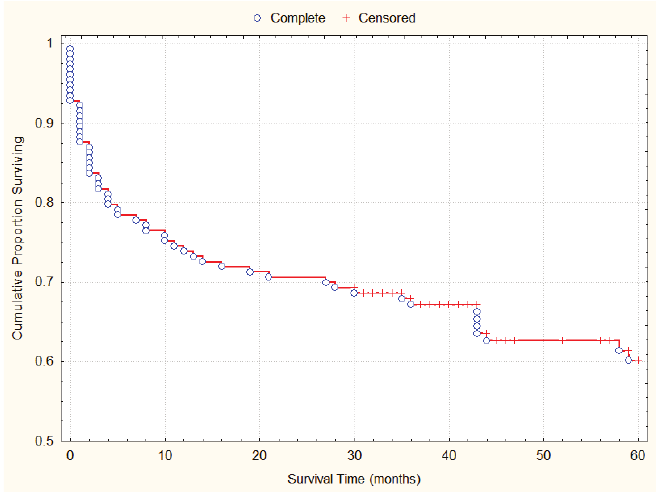
FIGURE 1 - Patient survival (Kaplan-Meier) after conventional OLT without VVB. The 1-, 2-, 3- and 5-year cumulative survival were 74.5%, 70.6%, 67.9% and 60.1%; respectively.